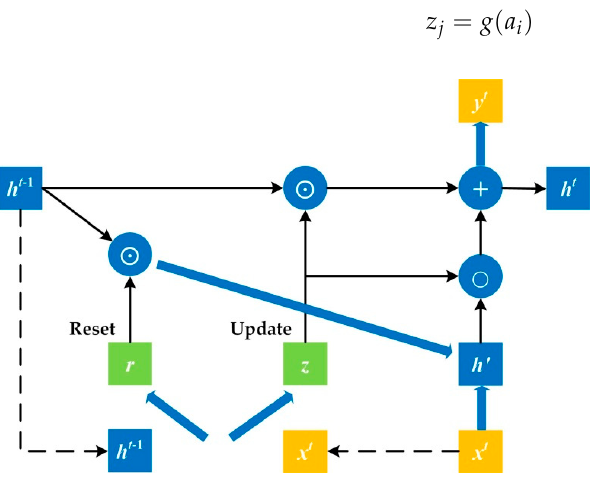
Figure 6. Structure of GRU.